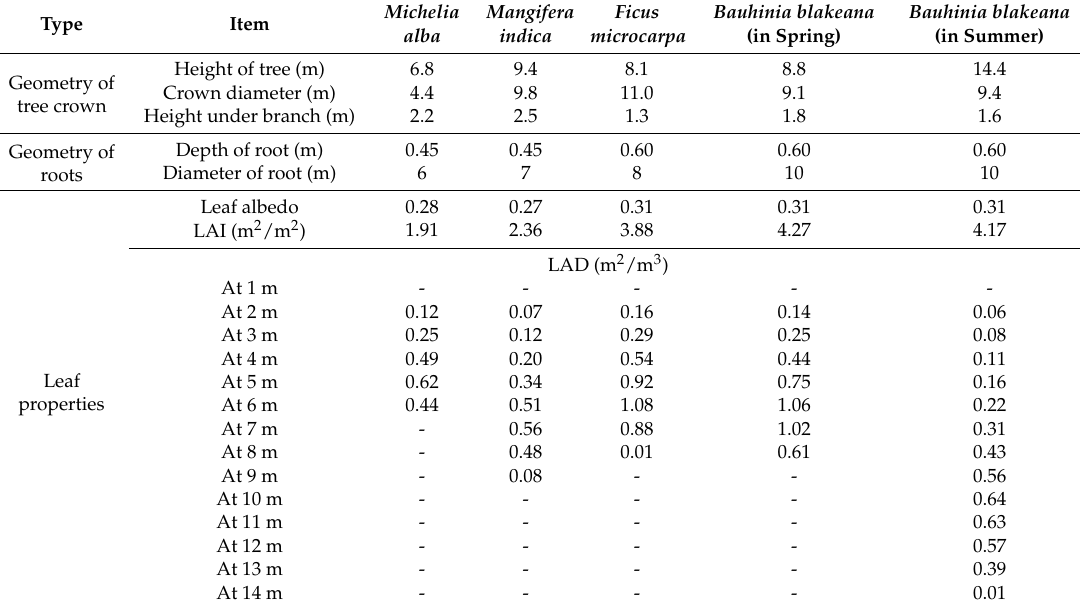
Table 1. The physical parameters of the studied trees. LAD: leaf area density; LAI: leaf area index.